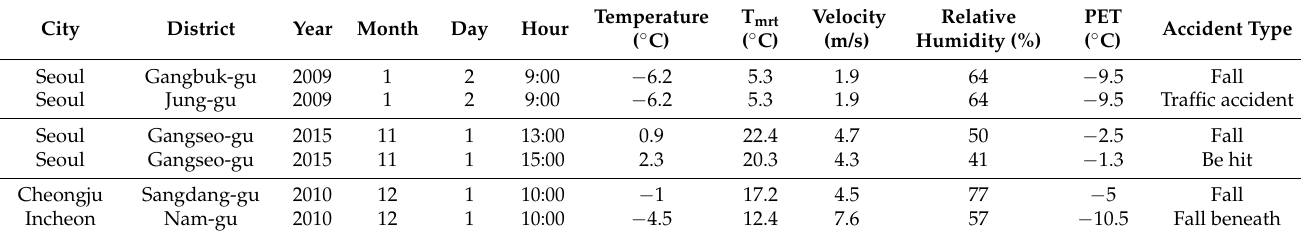
Table 2. Example of matching between accident data information and climate information considering city, district, and